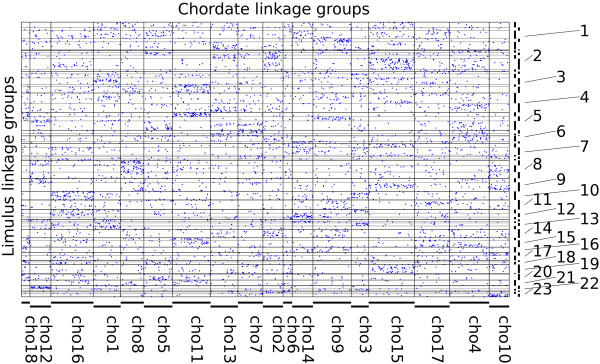
Limulus-Human macro-synteny dot plot as in Figure4, showing breaks introduced by hidden Markov model segmentation of the linkage groups as vertical lines.